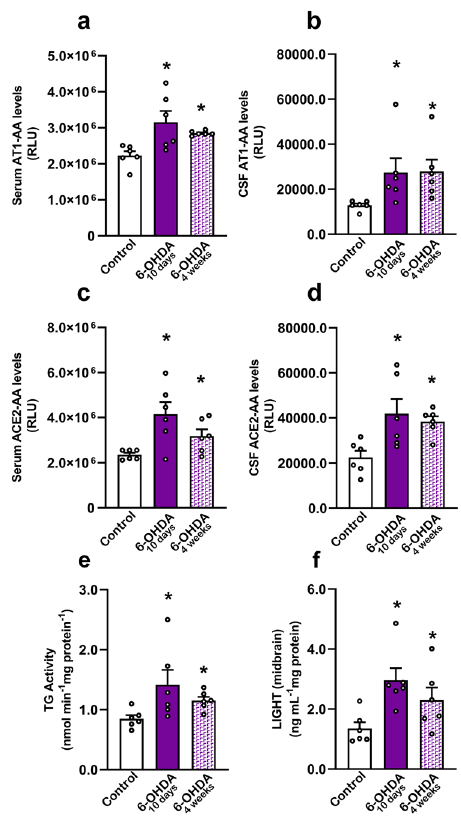
Fig. 2 Increase in serum and CSF AT1-AA and ACE2-AA levels induced by dopaminergic degeneration in rats. Serum levels of AT1-AA ( a ) and ACE2-AA ( c ) 10 days and 4 weeks after 6-OHDA injection (i.e. in the acute period of degeneration and neuroin- fl ammation and when the lesion is stabilized and neuroin fl amma- tion has decreased, respectively). A signi fi cant increase in AT1-AA ( b ) and ACE2-AA ( d ) is observed in CSF 10 days and 4 weeks after 6-OHDA injection. A signi fi cant increase in levels of LIGHT cytokine ( f ) and transglutaminase activity ( e ) is observed in the nigral region 10 days and 4 weeks after 6-OHDA lesion, which may contribute to the increase in autoantibody production. Data are given as means ± SEM. * P < 0 .05 compared to the control group. Kruskal – Wallis One Way Analysis of Variance on Ranks with Student-Newman-Keuls Method post hoc test ( a – c , e , f ) and one-way ANOVA followed by